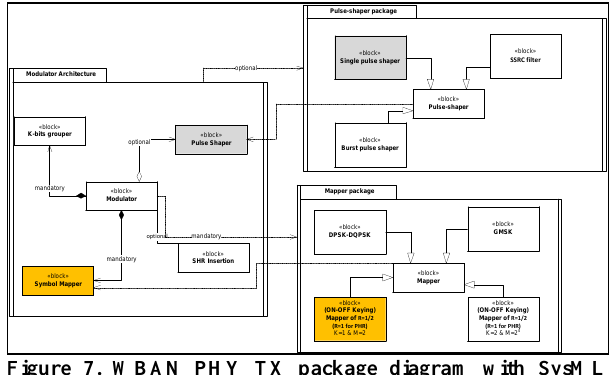
Figure 7. WBAN PHY TX package diagram with